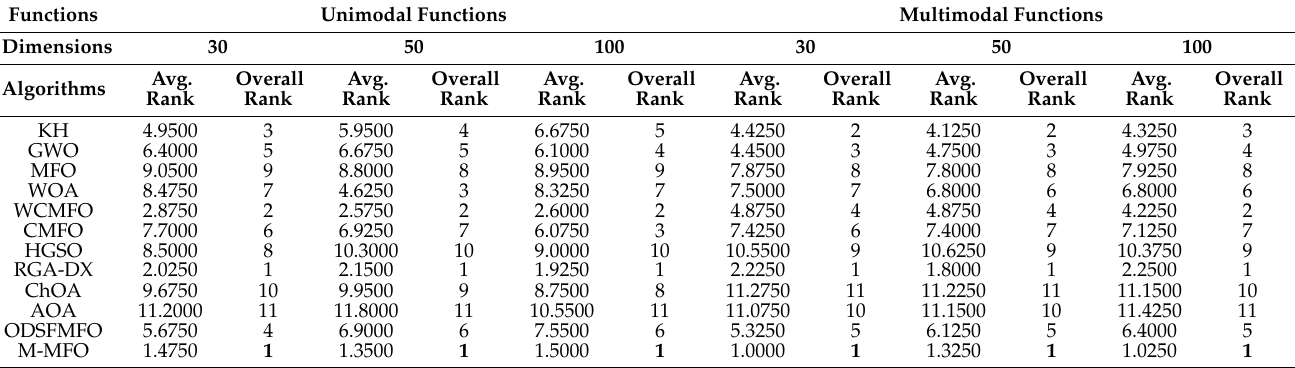
Table 8. Friedman test for unimodal and multimodal functions of the CEC